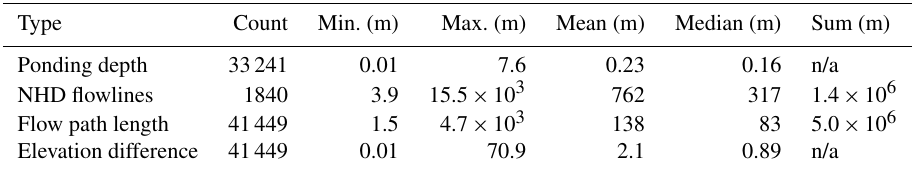
Table 4. Summary statistics of wetland depression ponding depth, NHD flowlines, flow path length, and elevation difference. n/a = not